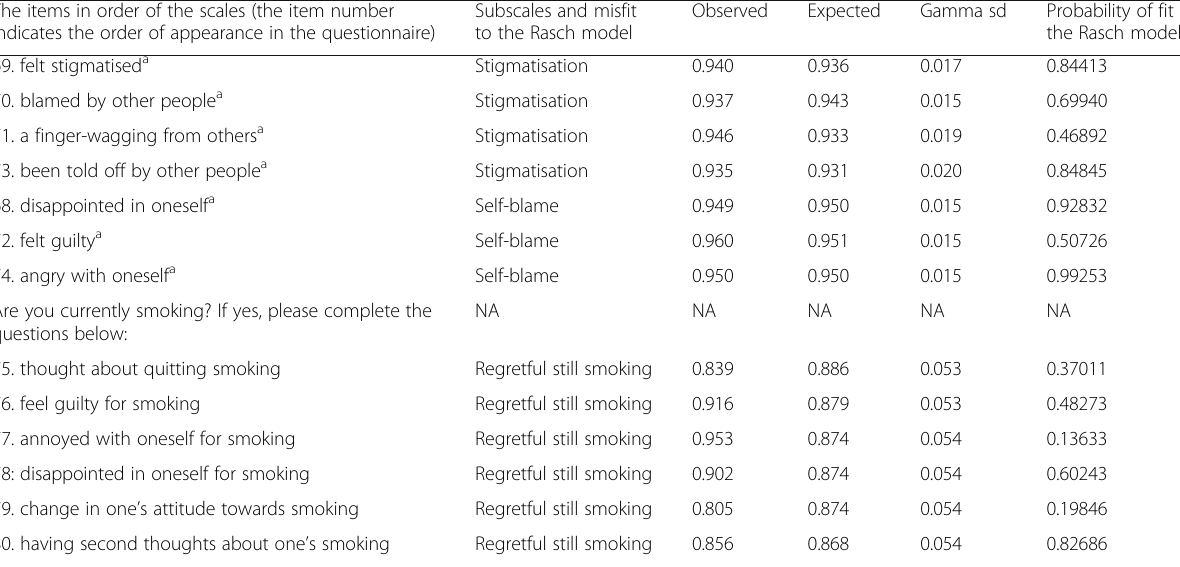
Table 4 Summary of result from the psychometric analyses of item to former and current smokers The items in order of the scales (the item number indicates the order of appearance in the